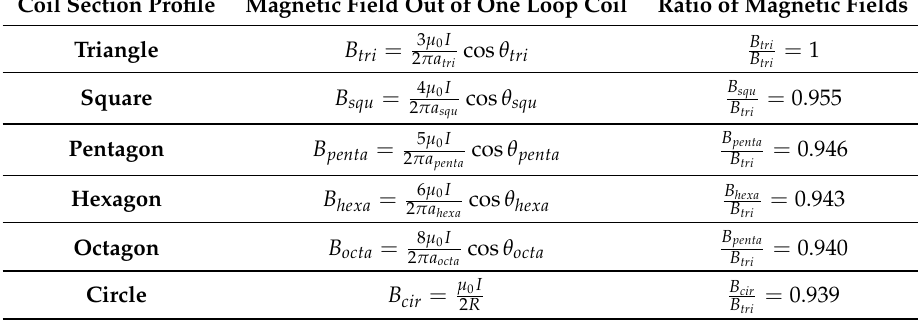
Table 4. Comparison of the produced magnetic fields and the forces among various coil cross-section